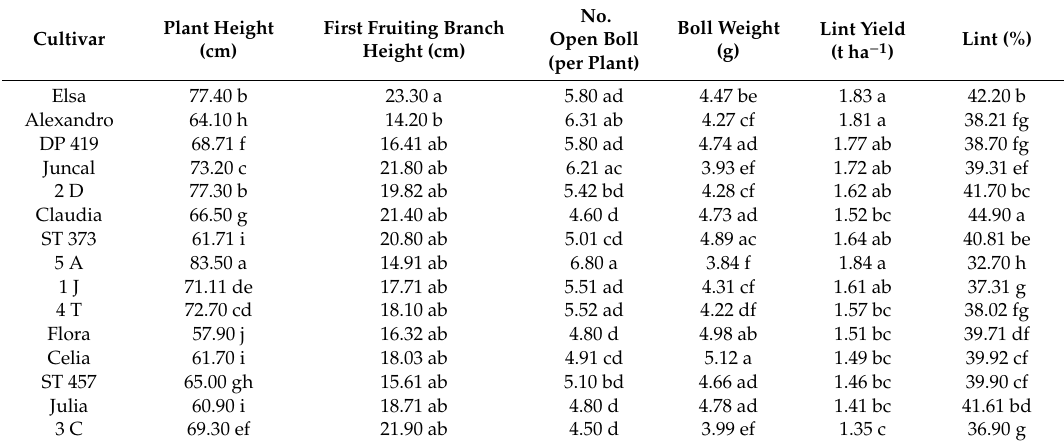
Table 3. Main morphological and yield traits of 15 cotton cultivars during the year 2011. Cultivar